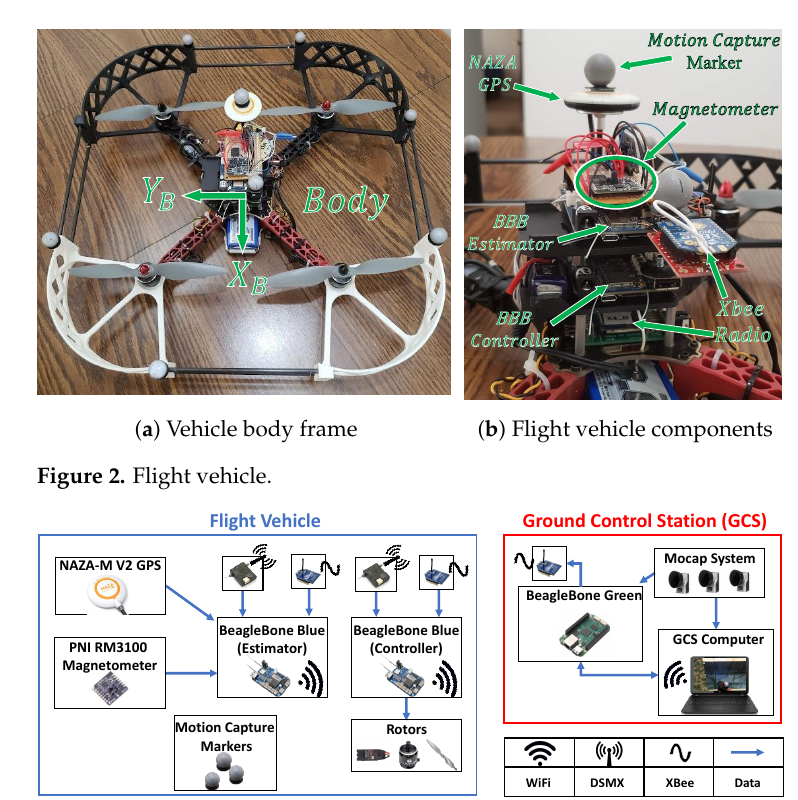
Figure 3. Diagram of the devices used to the gather experimental data. The estimator BB-Blue logs data from the NAZA-M V2 GPS, PNI RM3100 magnetome- ter, MPU9250 IMU (gyro and accelerometer), BMP280 barometer, and Qualisys